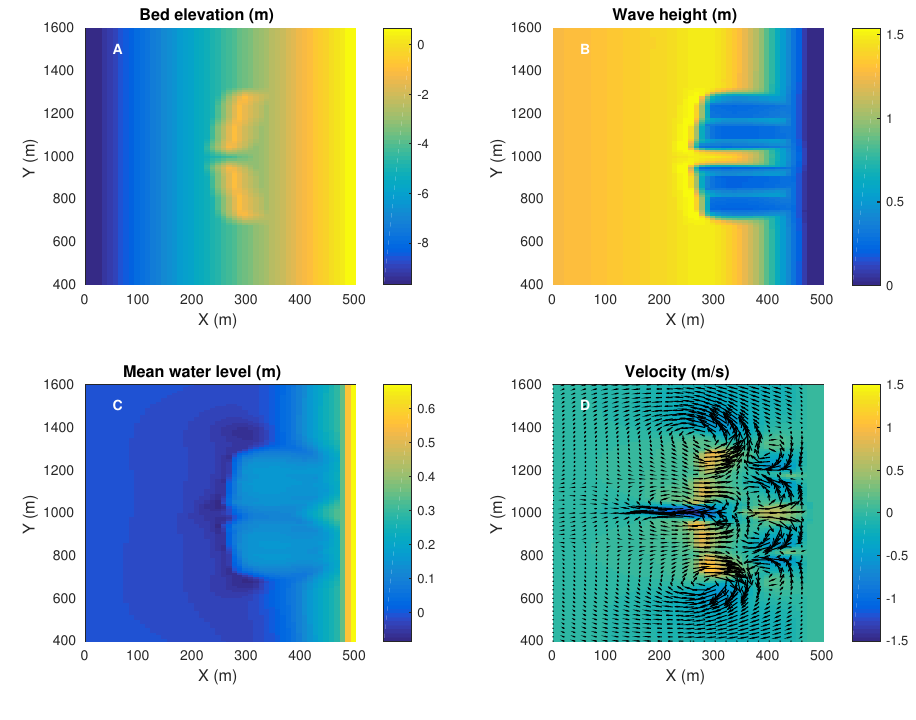
Figure 3. Reference case hydrodynamics. ( A ) Bed elevation. ( B ) Wave height. ( C ) Mean water level. ( D ) Contour of cross-shore velocity and velocity vectors field (only one fourth of the computational points are shown). Positive velocity correspond to onshore directed